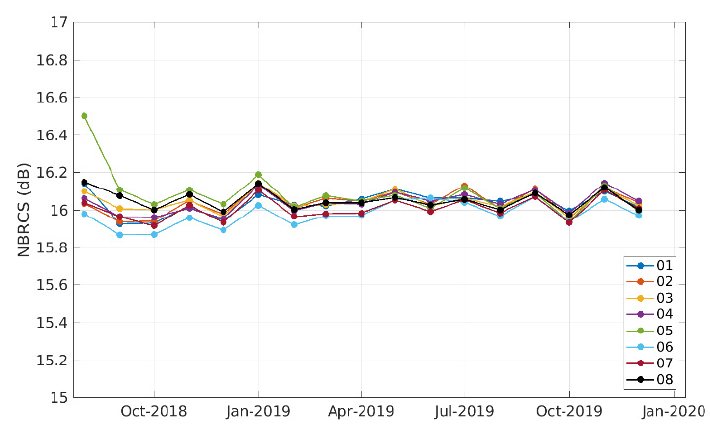
Figure 2. Temporal evolution of NBRCS estimates at ERA5 U10 ~7 m/s for all SVNs, segmented by CyGNSS Flight Model (FM01-FM08).